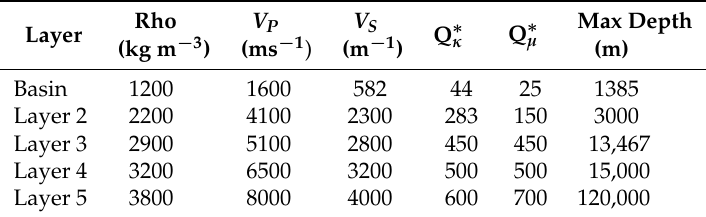
Table 1. Domain parameters used in